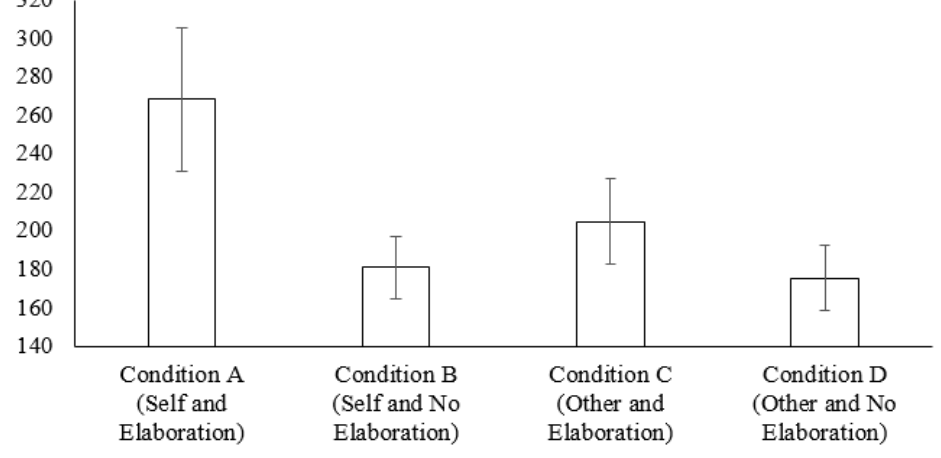
Figure 3. Mean percentage of temporal improvement in posttest in relation to pretest for each experimental condition and error bars. Table 2. Descriptive data for each condition regarding the percentage time tolerating pain at posttest in relation to pretest and pre – post change in pain intensity.